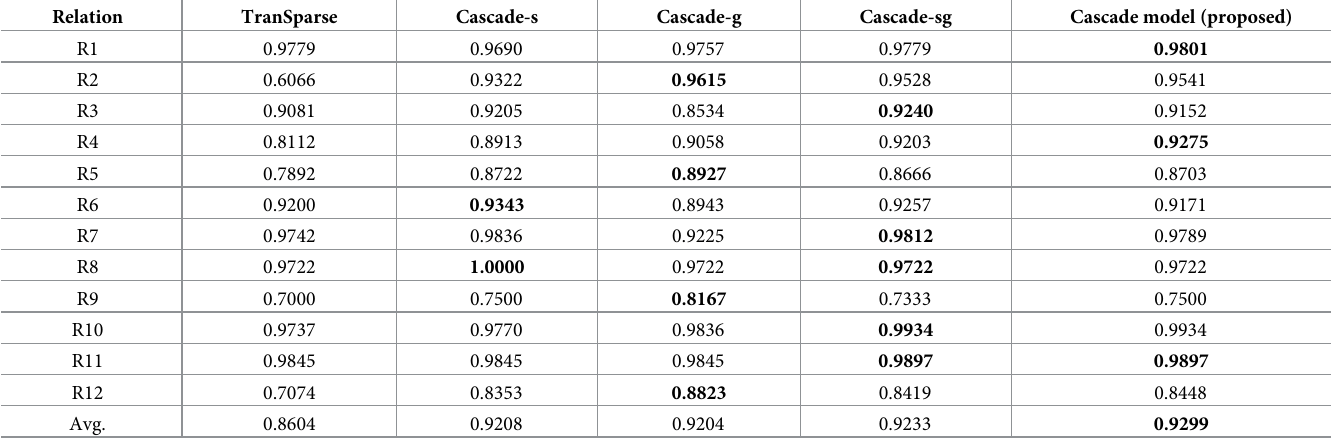
Table 2. Link prediction results